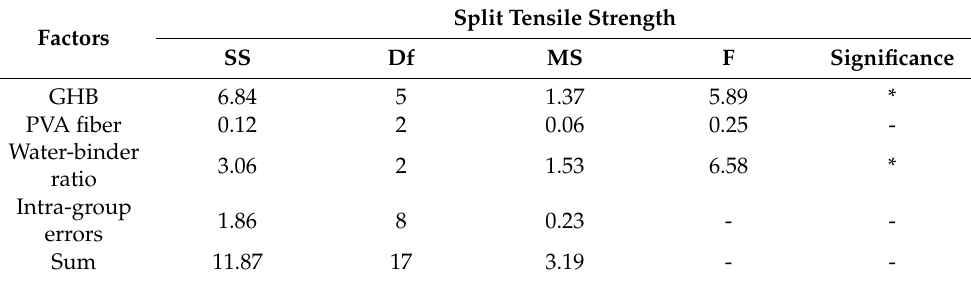
Table 7. Variance analysis results of split tensile